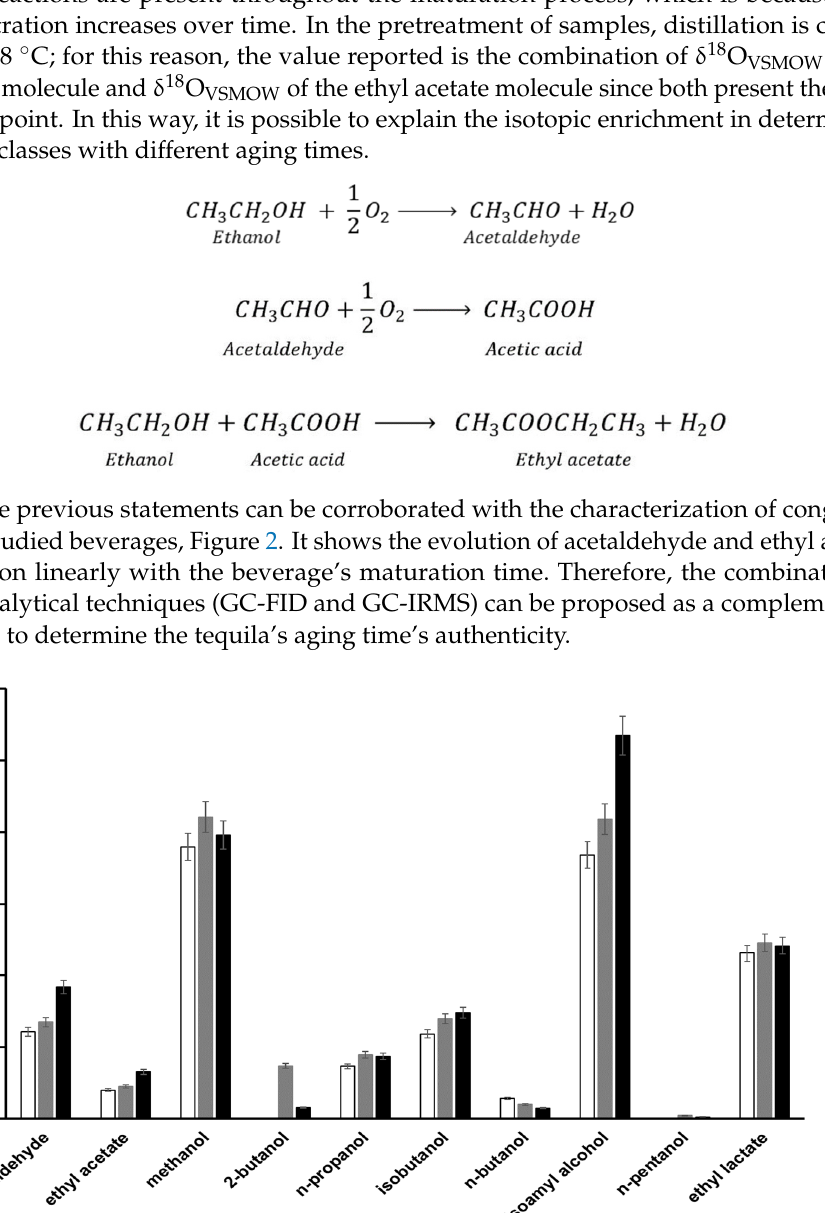
Figure 2. Chromatographic characterization of the 100% agave tequila congeners; class: □ silver, ■ aged, and ■ extra-aged.